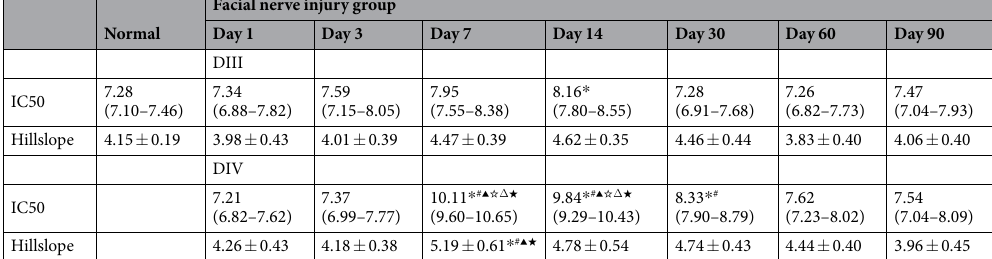
Table 1. IC50 values and slopes of the rocuronium dose-response curves for the normal, DIII (grade III), and DIV (grade IV) facial nerve injury groups. IC50 values and slopes at the IC50 are means with 95% confidence intervals and means ± standard deviation, respectively. * P < 0.05 vs. normal; # P < 0.05 vs. day 1; ▴ P < 0.05 vs.